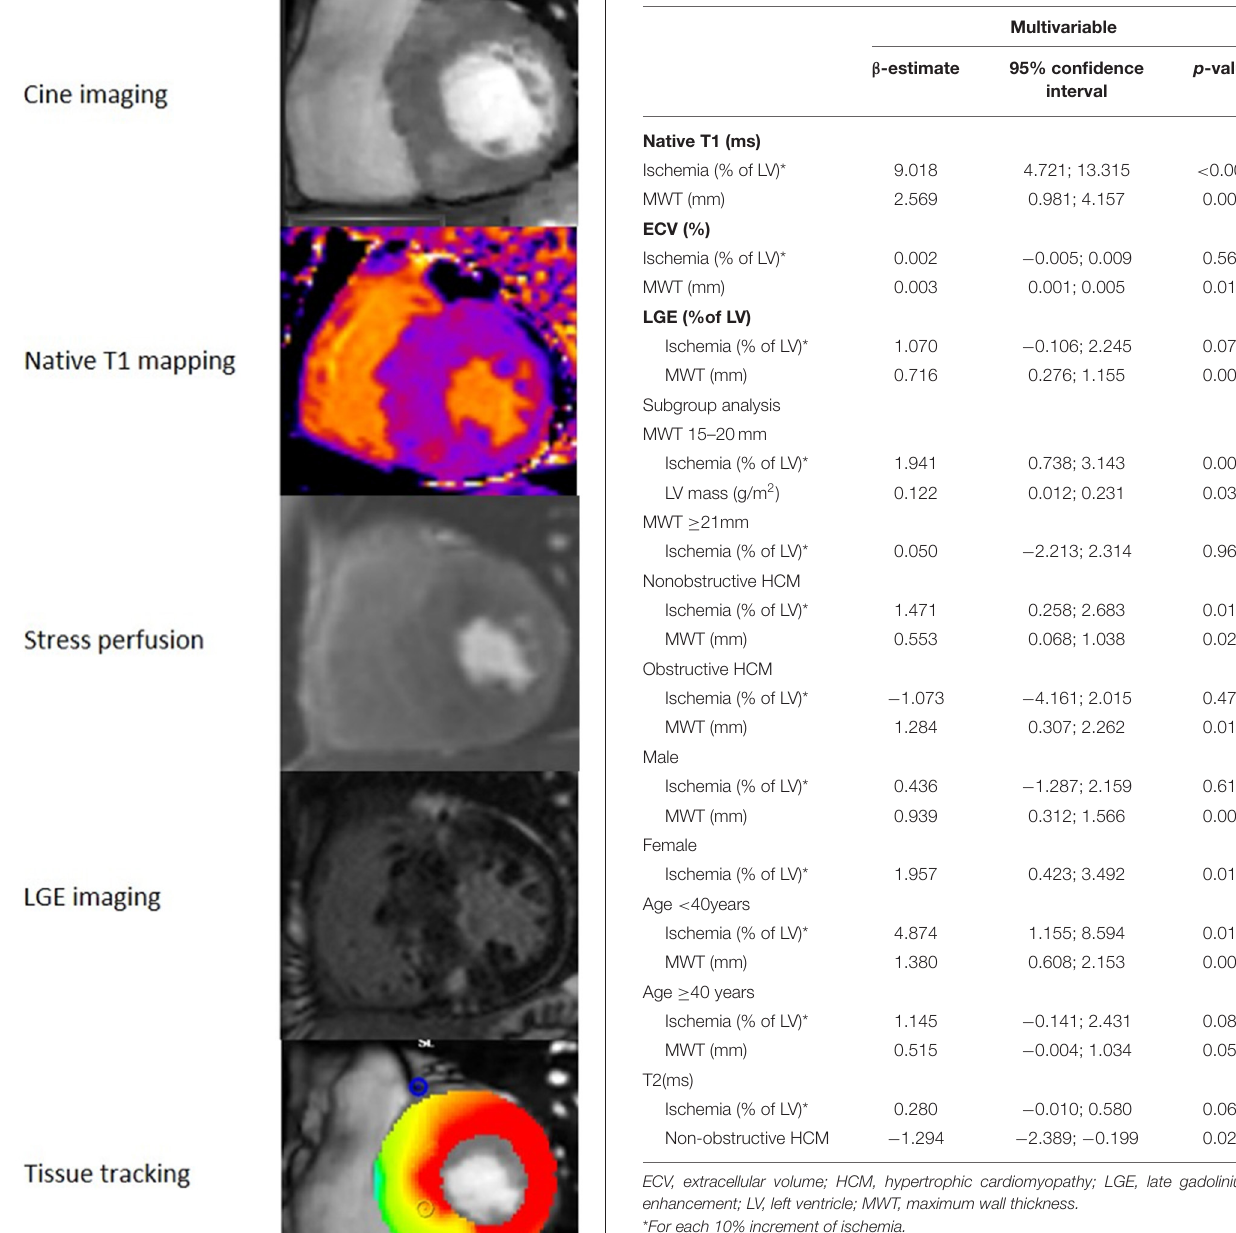
TABLE 4 | Multivariable linear regression for factors related to tissue